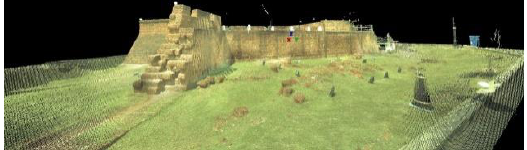
Figure 4. Visualizing of Bastion Middleburg monuments point cloud data from perspective view